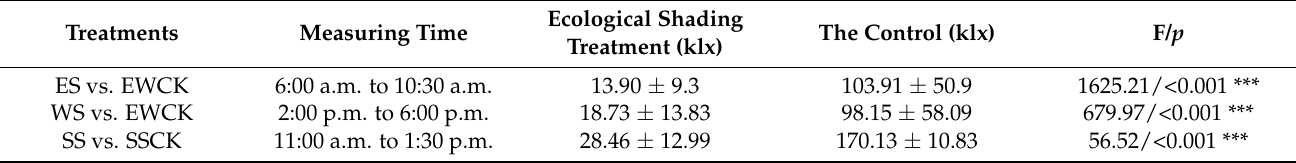
Table A1. One-way repeated measures ANOVAs of light intensity on the tea canopy of the ecological shading treatments of ES, WS, and SS, and their respective control treatments of EWSS and SSCK (values were Means ± sd, *** p <